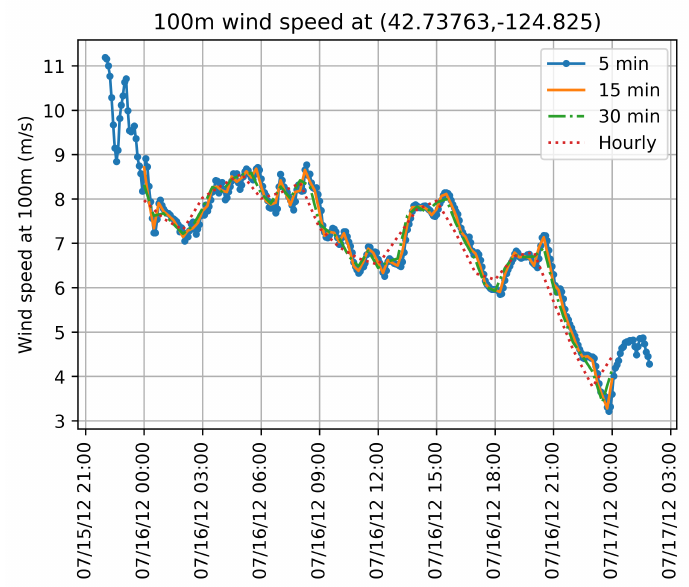
Figure 1. Data extracted from the WIND Toolkit, summed at 15-, 30-, and 60-min intervals, and at a location corresponding to approximately 30 km west of Port Orford.